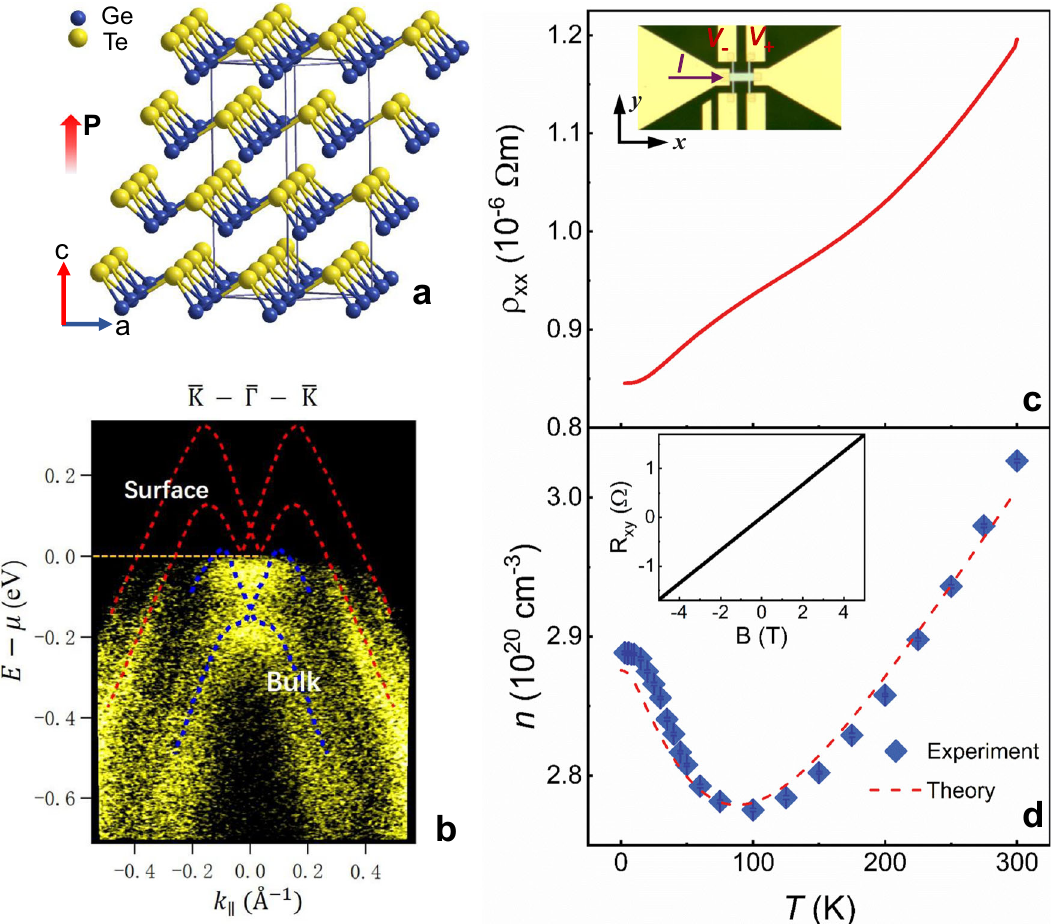
Fig. 1 Basic characterizations of α -GeTe fi lms. a Schematic illustration of rhombohedral crystal structure of α -GeTe. b ARPES band map along K (cid:1) Γ (cid:1) K direction measured at 5 K. The red and blue dashed curves trace the surface and bulk Rashba states, respectively. c Temperature dependence of the resistivity ρ xx . The inset is an optical image of α -GeTe device. d Experimental value of the carrier concentration n , as well as the theoretical predication, is plotted as functions of temperature. The inset shows a representative example of the Hall resistivity R xy with the magnetic fi eld at 10